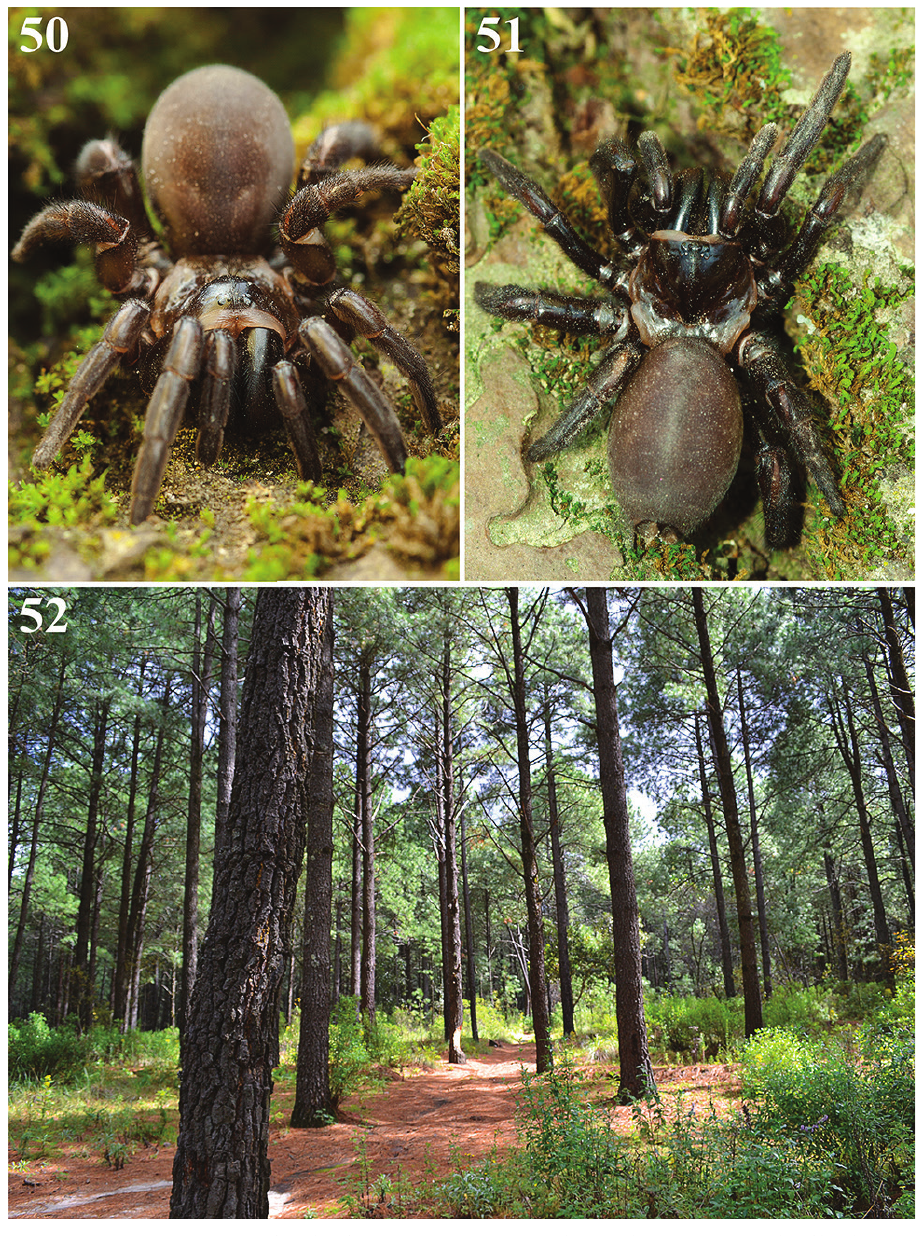
(photos by Victor H. Jiménez Arcos) 52 Pine forest of the Parque Nacional la Malinche (PNLM), Tlax- cala, Mexico, where the specimens of E. zapatista used for this study were collected (photo by Alejandro Valdez